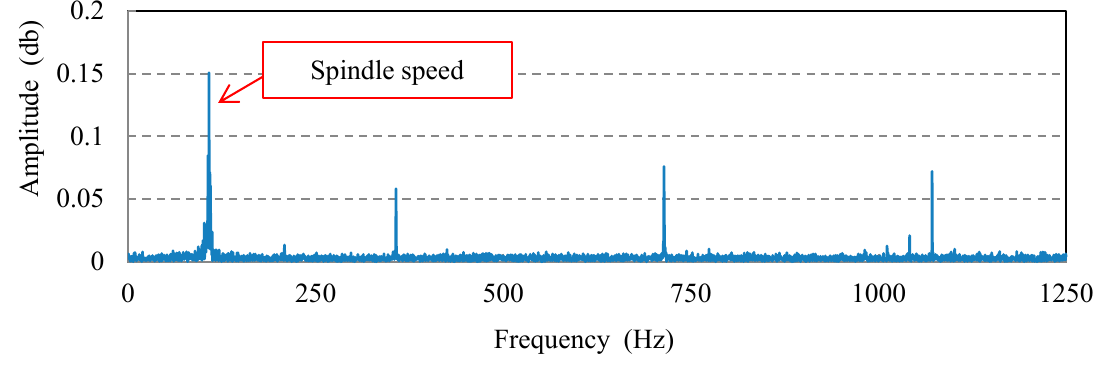
Figure 6. Bending moment spectrum under idling (spindle speed: 6000 rpm).